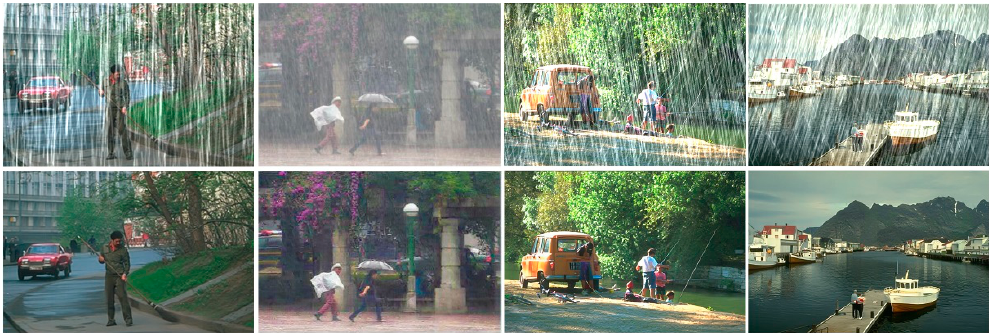
Figure 7. The visualization of